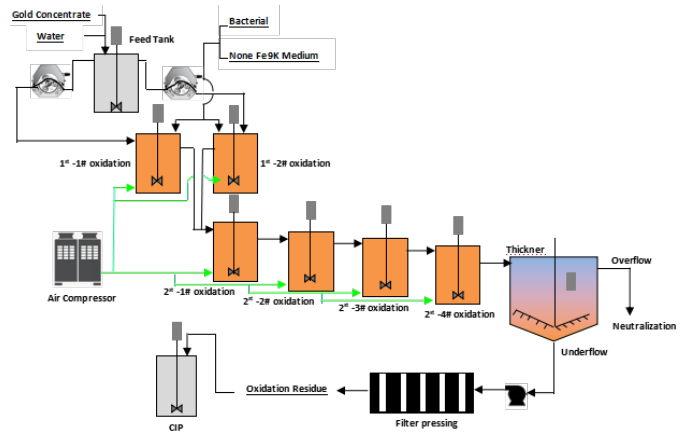
Figure 3. Flowsheet of continuous